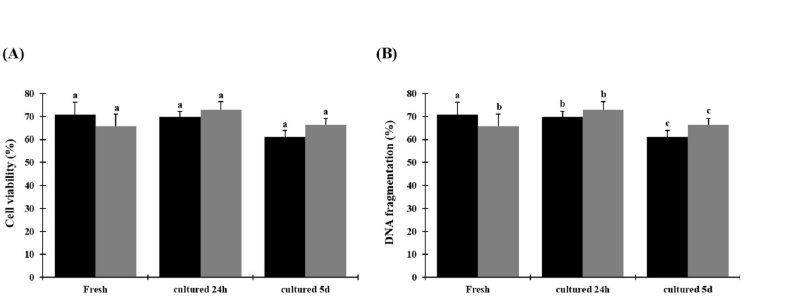
Fig 7. Cell viability and DNA fragmentation from prepubertal cats after warming, 24 h, or 5 days of in vitro culture. (A) cell viability, (B) cells with fragmented DNA. Data are expressed as mean ± SE (n = 5 animals per treatment). Black bars indicate fresh tissue and grey bars indicate vitrified tissue. Different letters above bars indicate significant statistical differences between treatments (P < 0.05).